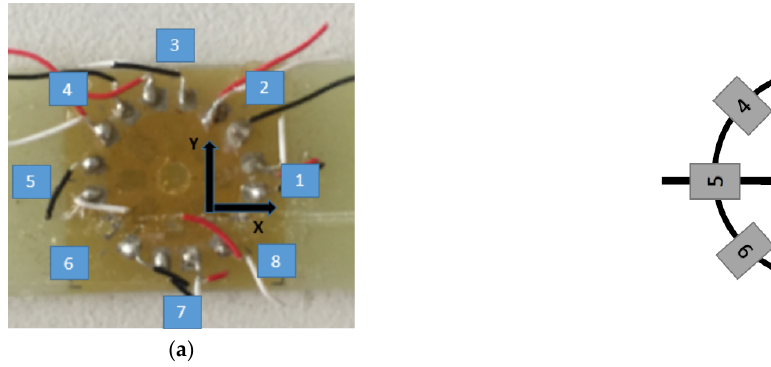
Figure 3. ( a ) Sample and ( b ) sketch of the strain gauge rosette with eight grids used for measuring strains in glass fiber reinforced plastic (GFRP) upon